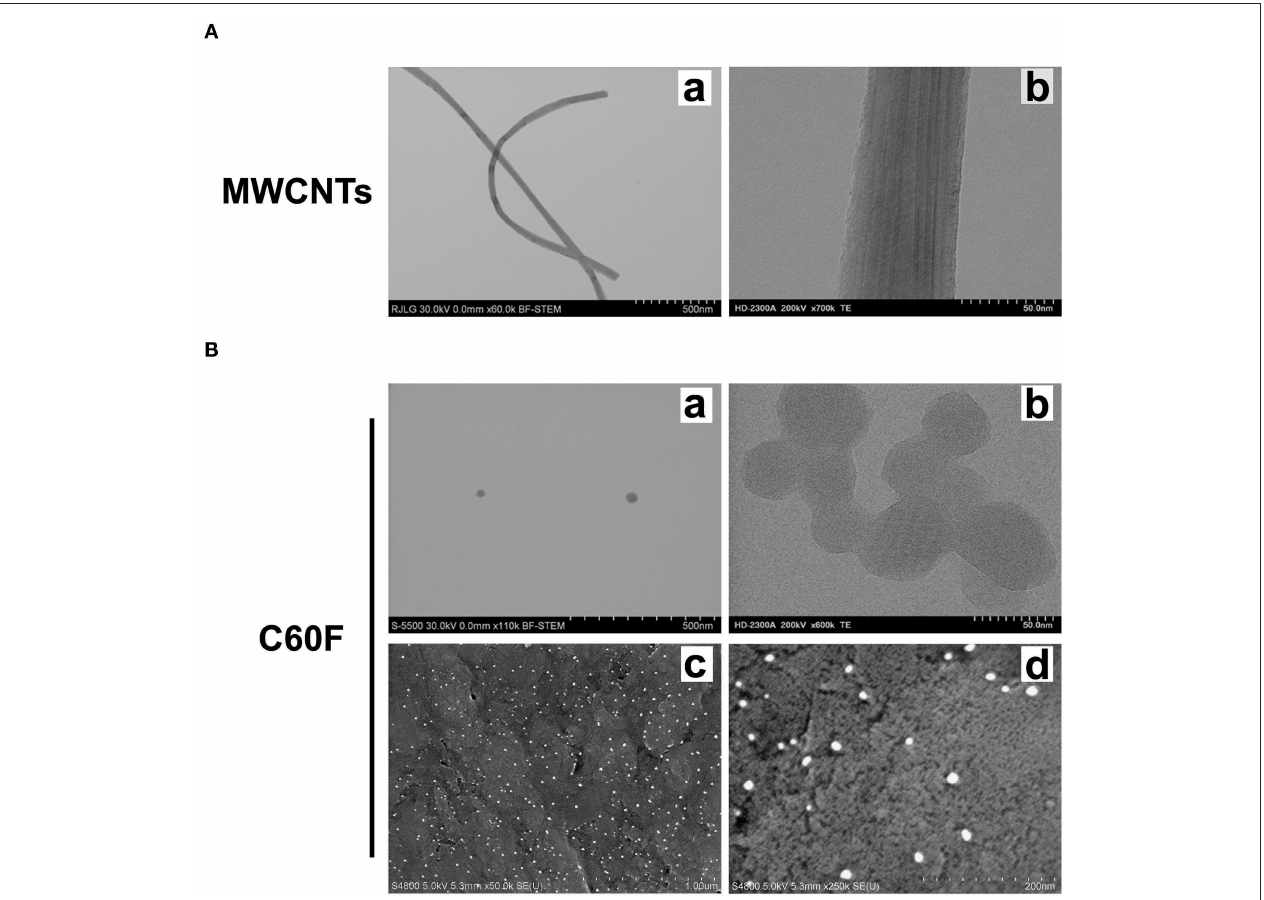
FIGURE 1 | Morphological characterization of MWCNTs and C60F. (A) Morphology of MWCNTs. A representative low (a) or high (b) magnification TEM micrograph of MWCNTs showing the distinctive fiber-like shape and multi-walled structure of MWCNTs. (B) Morphology of C60F. For (a) and (b), a representative low (a) or high (b) magnification TEM micrograph of the C60F was shown demonstrating their distinctive spherical morphology. For (c) and (d), FESEM micrographs of C60F at a low (c) or high (d) magnification were shown confirming the spherical morphology and even